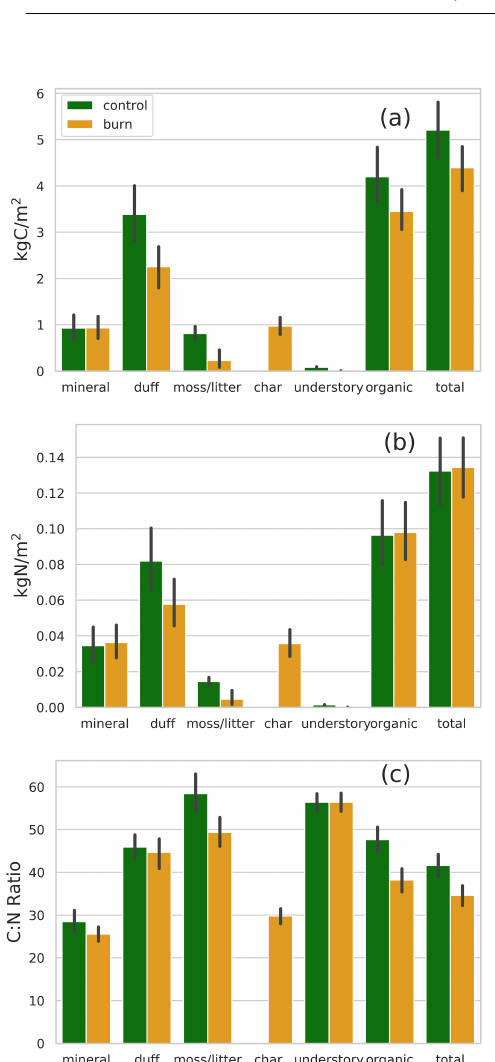
Figure 3. Mean C (a) and N (b) stocks and their ratio (c) between burnt and control plots amongst forest compartments. The organic category is considered the grouping of the duff, moss/litter, and char layers while the total category is the grouping of the organic and mineral soil layers along with the understory. Error bars are the bootstrapped 95% confidence interval of the